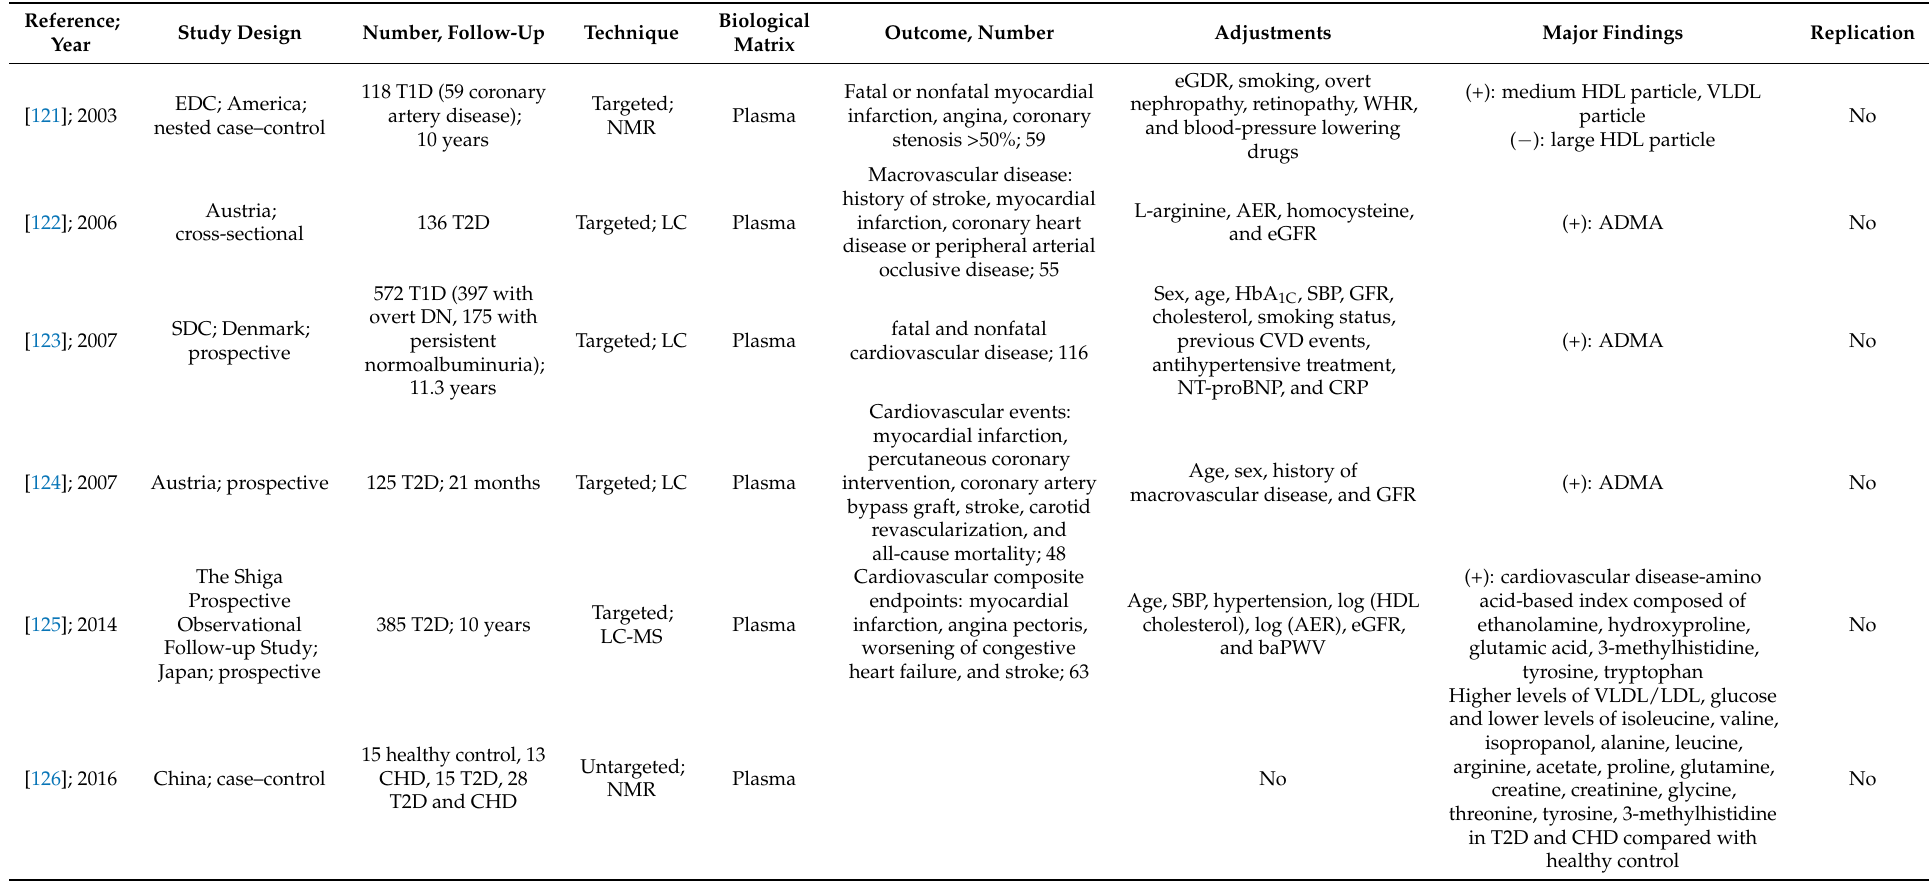
Table 4. Circulating metabolites associated with cardiovascular disease in individuals with